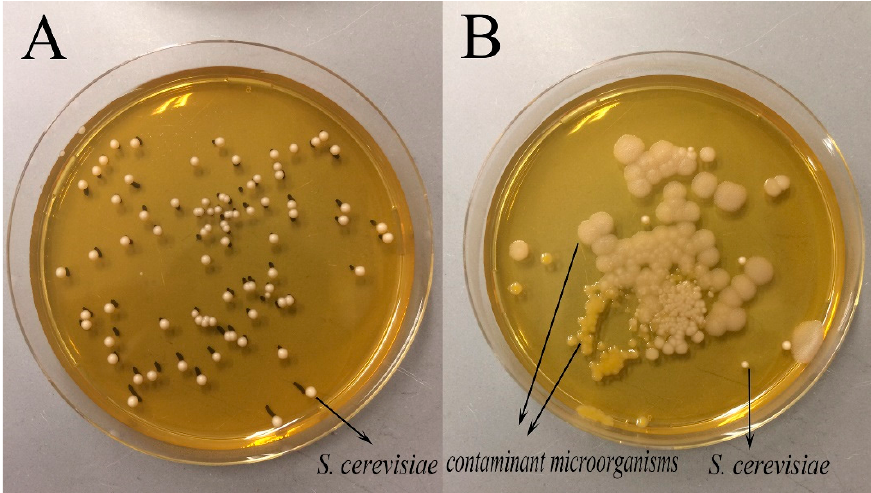
Figure 2. The growth of contamination on the yeast plate, ( A ) from dough fermented by S. cerevisiae 9Y3 and F. sanfranciscensis LS1, ( B ) from dough fermented by S. cerevisiae 9Y3